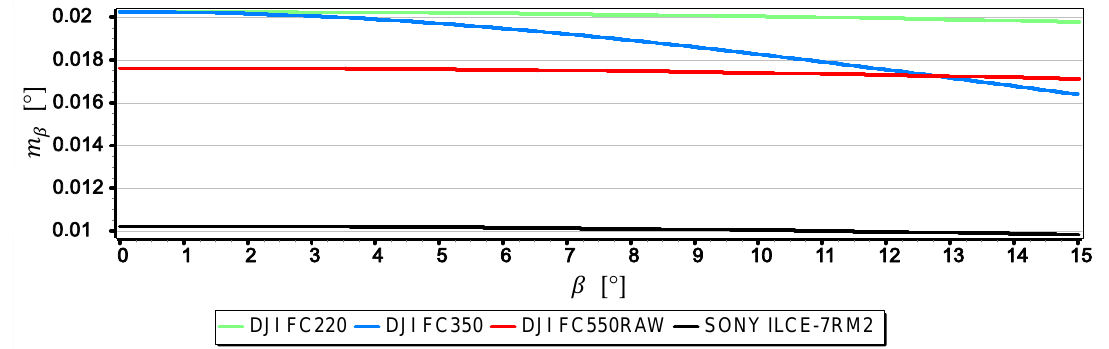
Figure 16. Mean error of measurement 𝑚 𝛽 as a function of the horizon slope 𝛽 .